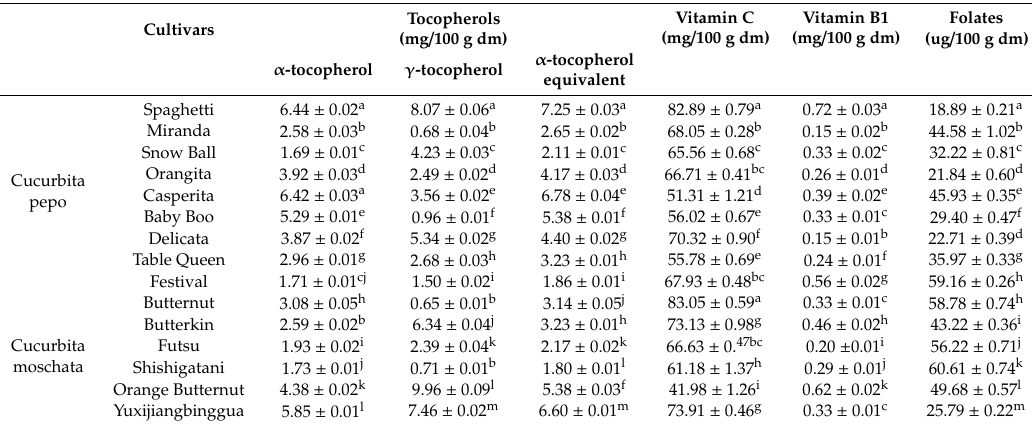
Table 4. The content of tocopherols, vitamin C, B1, and folates in pumpkin varieties.